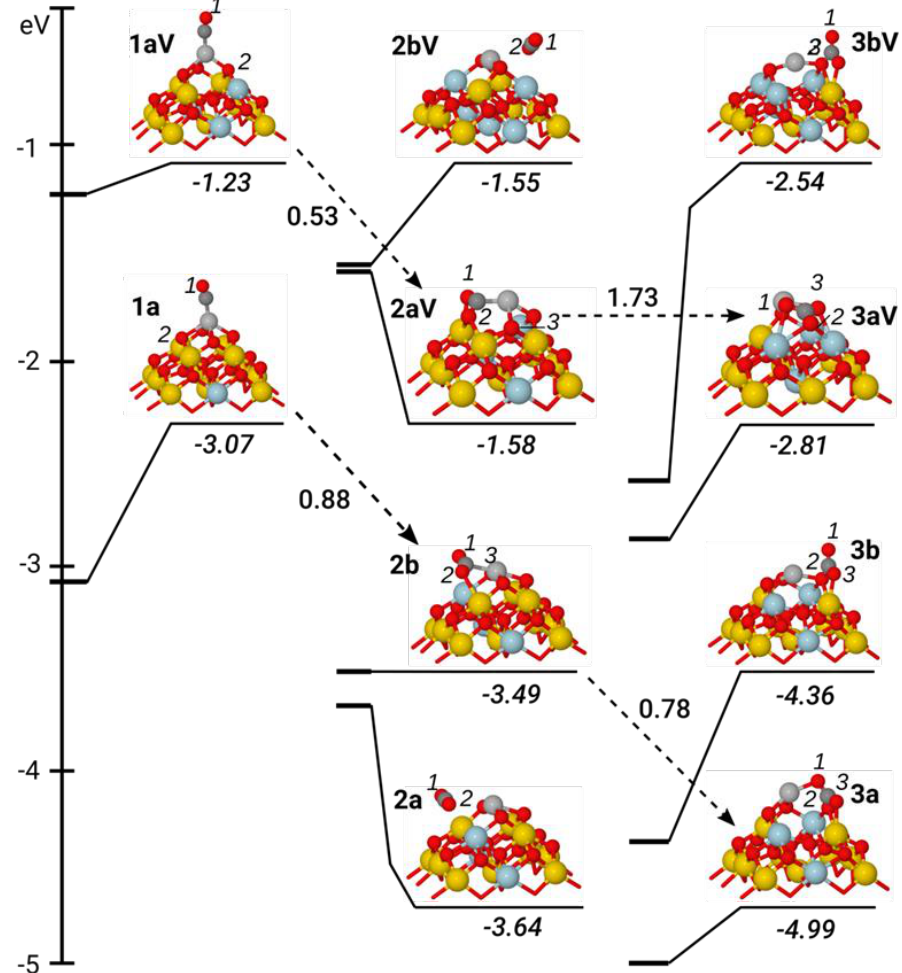
Figure 4. Structures and formation energies E f (in eV) of the complexes created by the interaction of CO with the Ag/Ce 21 O 42−n sites (n = 0, 1): AgCO/Ce 21 O 42 ( Ag1a ), AgCO/Ce 21 O 41 ( Ag1aV ), AgCO 2 /Ce 21 O 41 ( Ag2a, Ag2b ), AgCO 2 /Ce 21 O 40 ( Ag2aV, 2bV ), AgCO 3 /Ce 21 O 40 ( Ag3a, Ag3b ) and AgCO 3 /Ce 21 O 39 ( Ag3aV, Ag3bV ). Activation energies (E ≠ ) of selected transition states are shown near the dashed arrows connecting corresponding initial reagent and product. For further explanations, refer to the main text and the captions to Figures 1 and